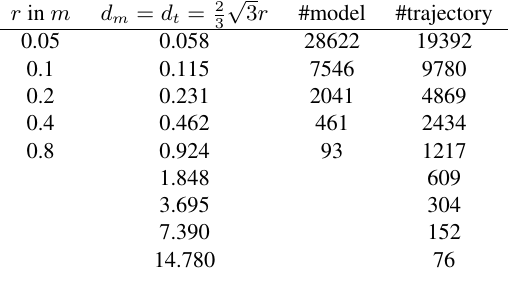
points computation time